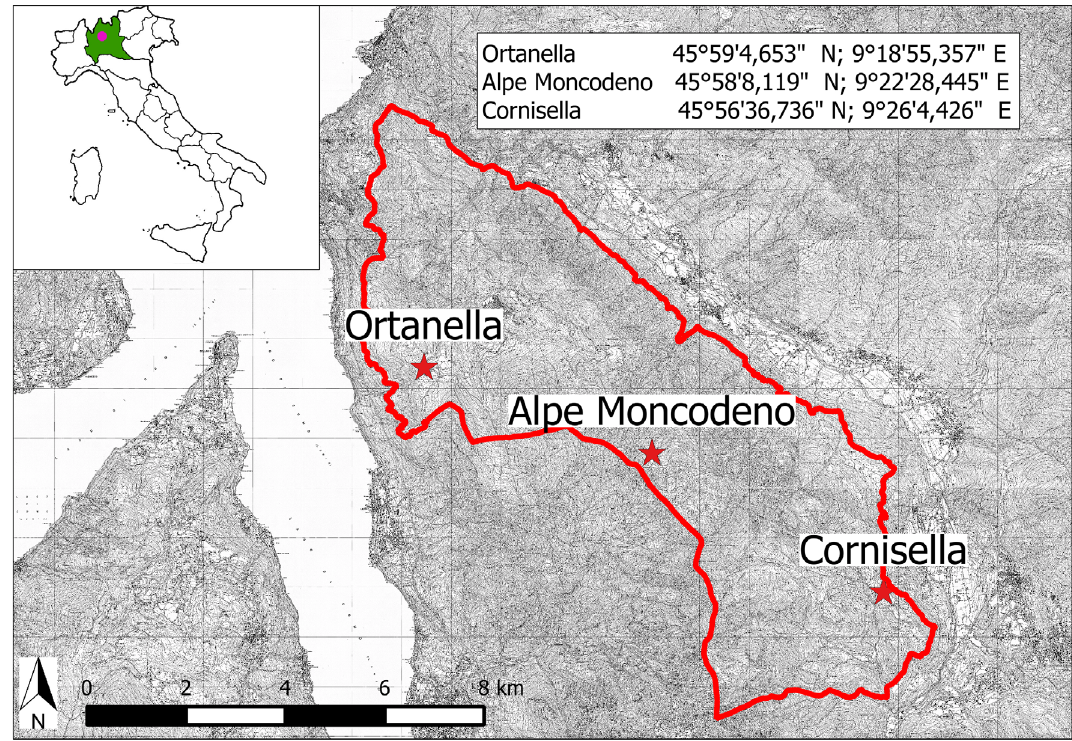
Figure 1. Sampling localities. Distribution map of sites where beehives for pollen collection were positioned within the Grigna Settentrionale Regional Park (red line). The full names and geographic coordinates for the collection sites are provided.